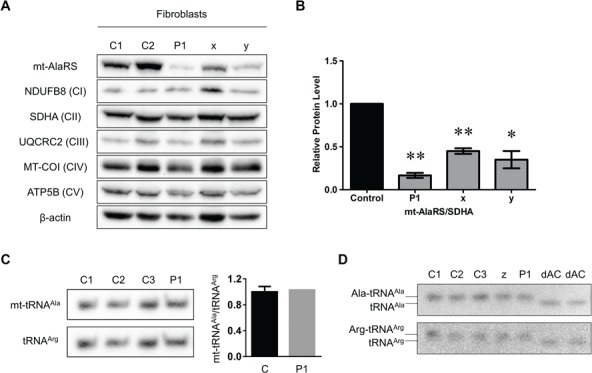
Western blot, northern blot and aminoacylation analysis in AARS2 patient fibroblast lysates. (A) Steady-state mt-AlaRS and OXPHOS subunit protein levels in Patient 1 (P1) and two control fibroblast lysates. Also shown are two reported AARS2 patients in the literature who were homozygous or compound heterozygous for the p.Arg592Trp founder mutation; Patient x (homozygous p.Arg592Trp) corresponds to Patient 11, and Patient y (p.Arg592Trp and c.2882C>T (p.Ala961Val)) corresponds to Patient 7 in (24). Antibodies against mt-AlaRS, NDUFB8 (CI), SDHA (CII), UQCRC2 (CIII), MT-COI (CIV) and ATP5B (CV) were used, with β-actin as a loading control. (B) Graph of relative mt-AlaRS protein levels (n = 3) in controls, Patient 1 (P1), Patient x (x) and Patient y (y) fibroblasts. All data were normalized to SDHA and represented as mean ± standard error of the mean. Significant difference between controls and patient fibroblasts is indicated by asterisks above the columns (*, P-value < 0.05; **, P-value < 0.01 by two-tailed paired students t-test). (C) Northern blot analysis of mt-tRNAAla levels in patient fibroblasts. (D) Aminoacylation assay showing aminoacylated (‘charged’) and deacylated (‘uncharged’) mt-tRNAAla in patient fibroblasts. Mitochondrial tRNAArg was used as a loading control. Lower bands in the dAc lanes denote fully deacylated control tRNA species. Patient z was homozygous for the p.Arg592Trp founder mutation and has been previously reported, corresponding to Patient 1 in (19).